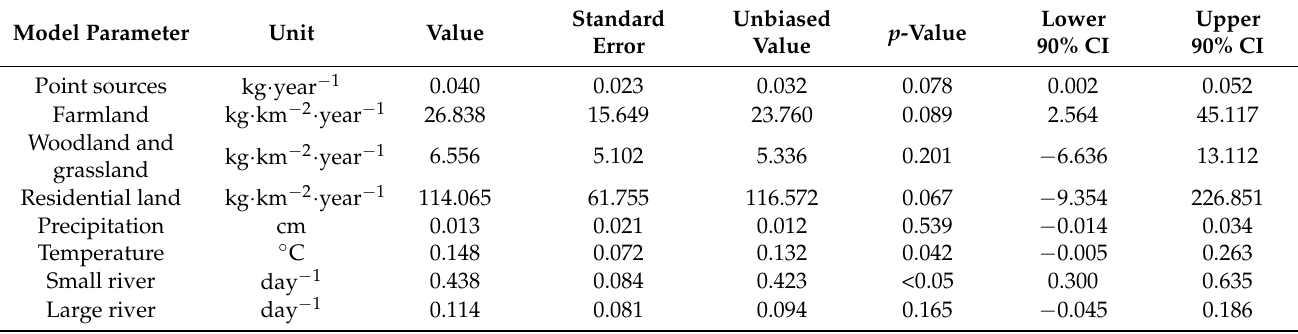
Table 4. Evaluation of parameters in